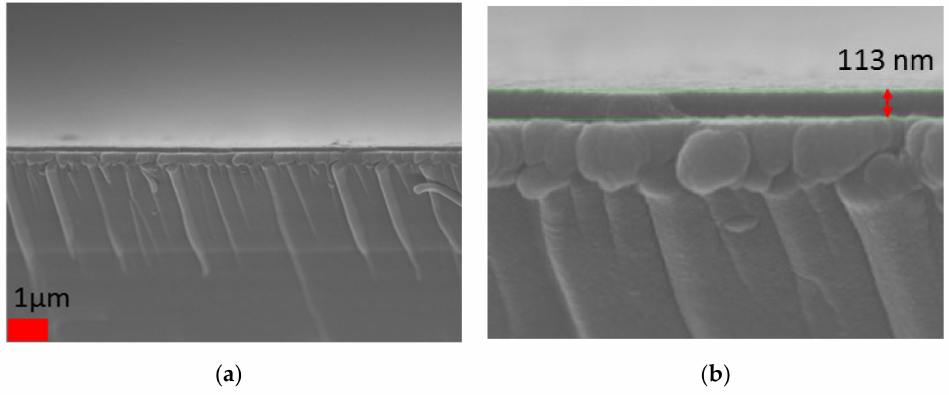
Figure 3. ( a ) Representative SEM image of the studied NiO thin film. ( b ) Amplification of ( a ) with green lines describing the thickness of the film.